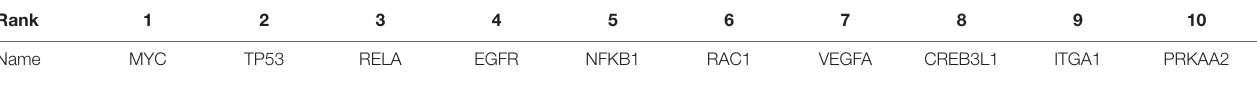
TABLE 1 | Top 10 nodes with the highest degree in the predicted differential network between insulin-resistant (IR) and insulin-sensitive (IS)